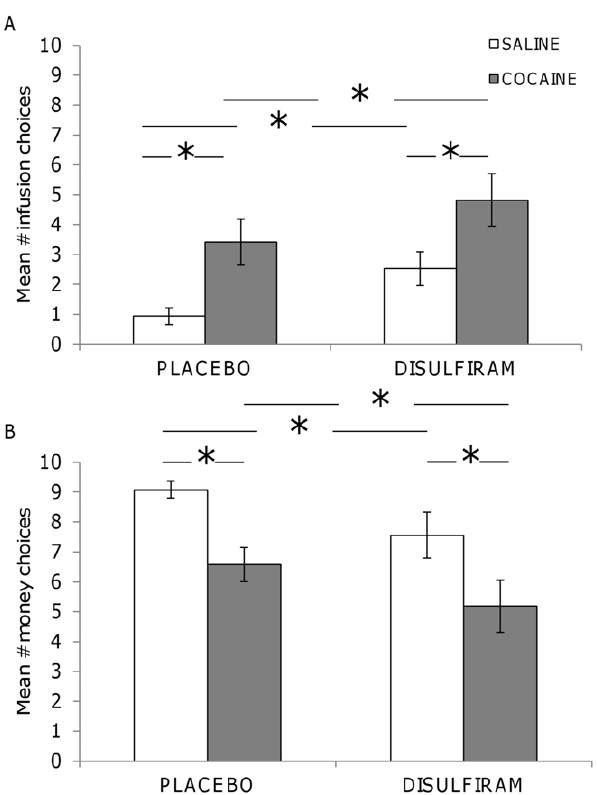
Figure 2. Disulfiram effects on choices in all participants. Impact of disulfiram (250 mg/day) on choices for saline and cocaine (20 mg/IV infusion, A.) and money of escalating value (B.) in non-treatment seeking cocaine-dependent participants (N=17,*=p , 0.05).